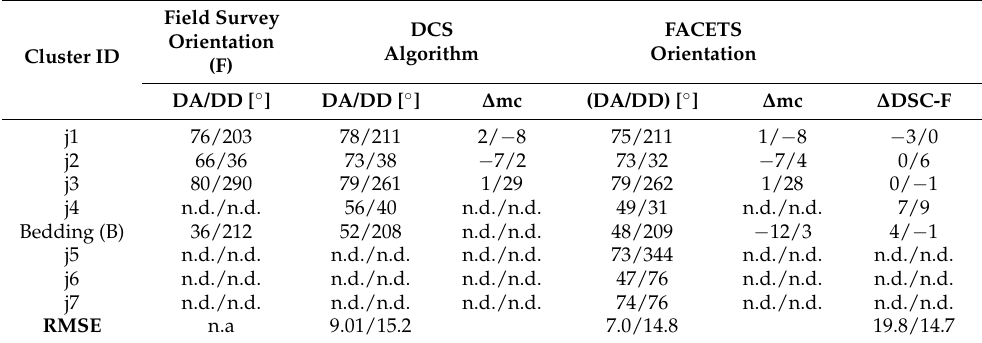
Table 2. Dip direction and dip angles of the poles of each identified discontinuity set. The relating number of points over the total number of points is reported in